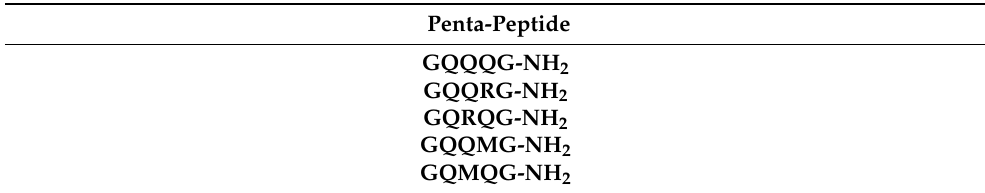
Table 1. Investigated penta-peptides. G , Gly, glycine, hydrophobic; Q , Gln, glutamine, neutral hydrophilic; R , Arg, arginine, positively charged; M , Met, methionine,